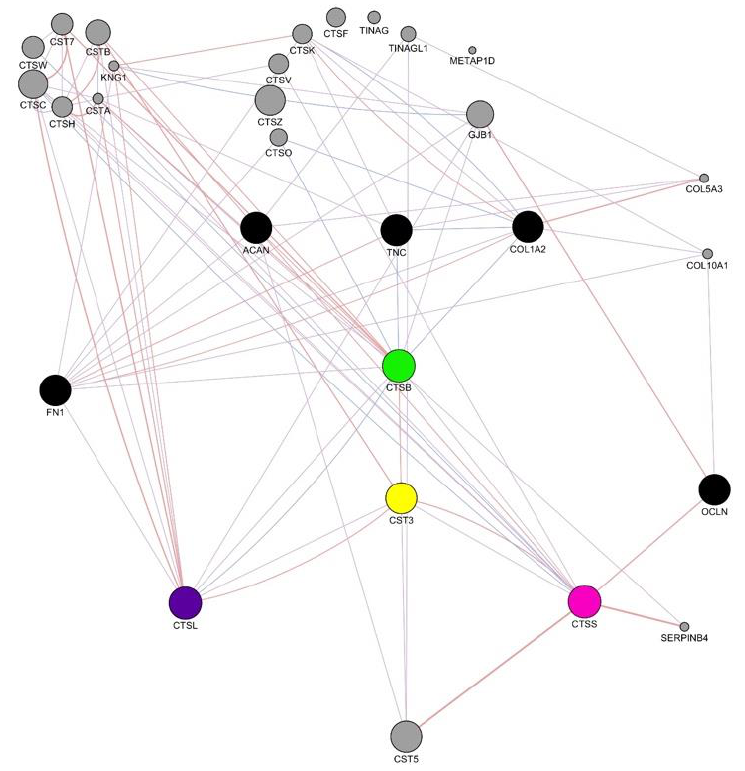
Figure 11. Human gene interaction network of cathepsin B (green), cathepsin L1 (purple), and cathepsin S (pink). Clinically significant gene interactions are shown in black.